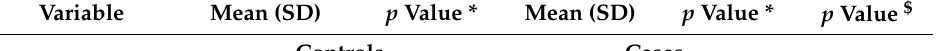
Table 2. Comparison of P16 INK4a expression by demographics and tumor